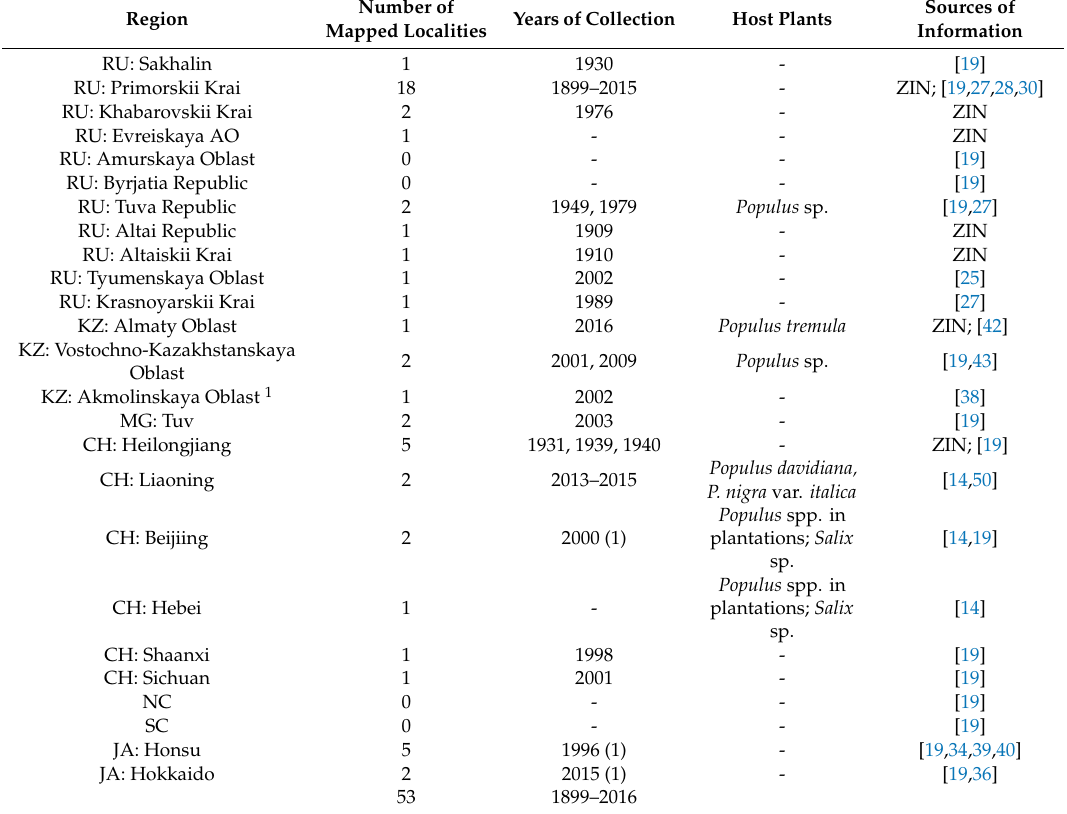
Table 2. Documented records of Agrilus fleischeri Obenberger, 1925. CH—China, JA—Japan, in ZIN; 1 —determination needs